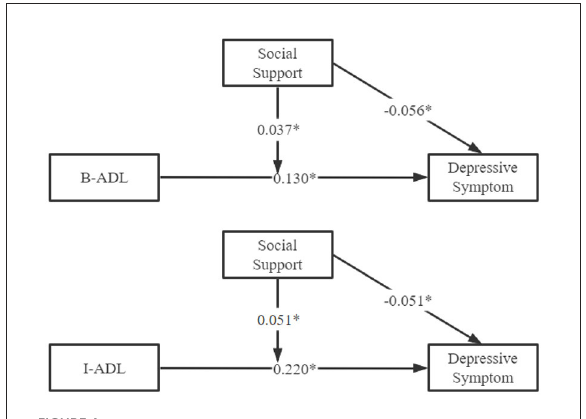
FIGURE4 Model of moderation by social support. * P <